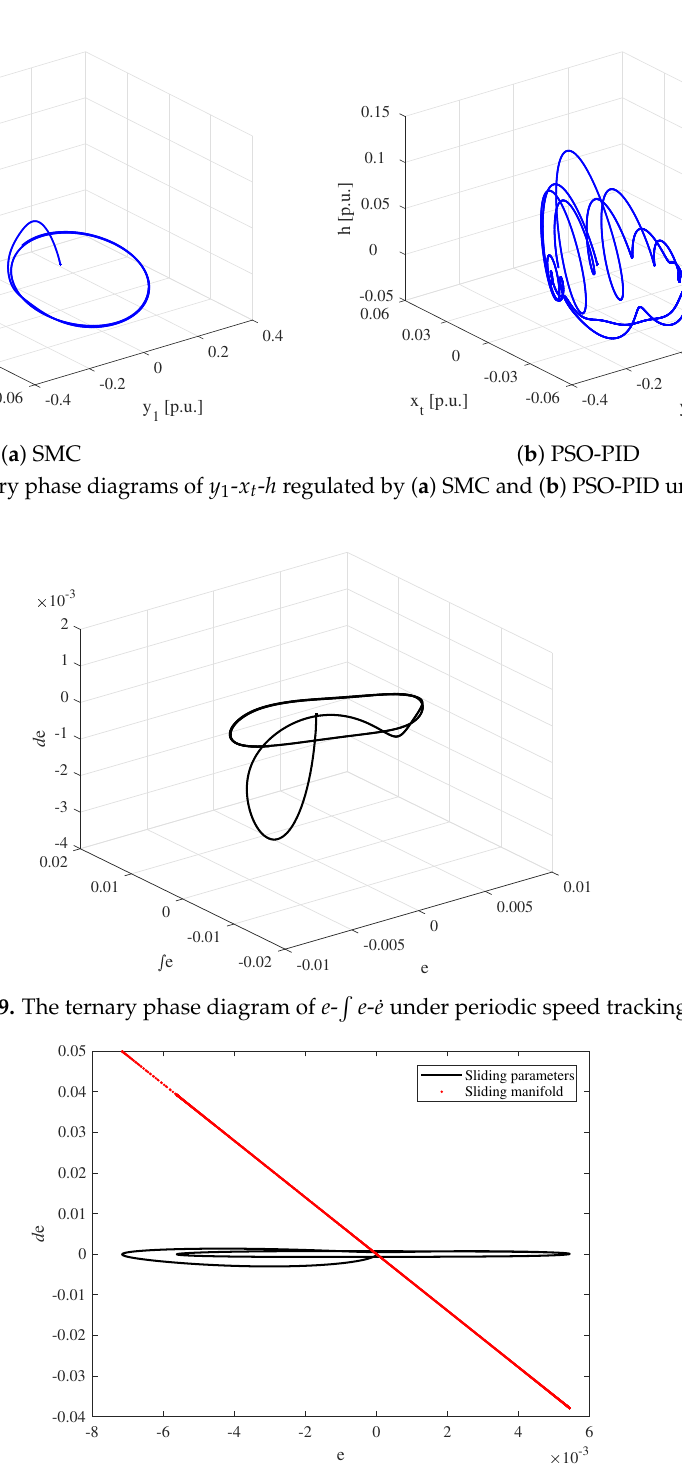
Figure 10. The plane phase diagram of e -˙ e under periodic speed